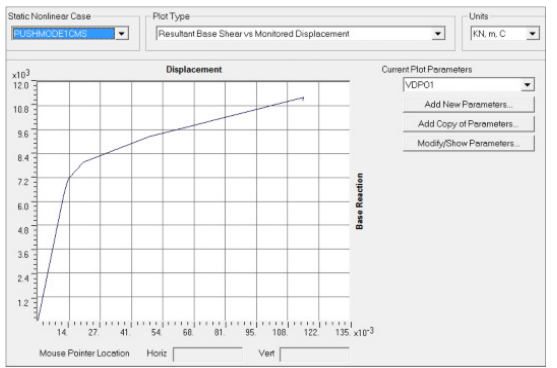
Fig. 9. Base shear vs. displacement in the transverse direction